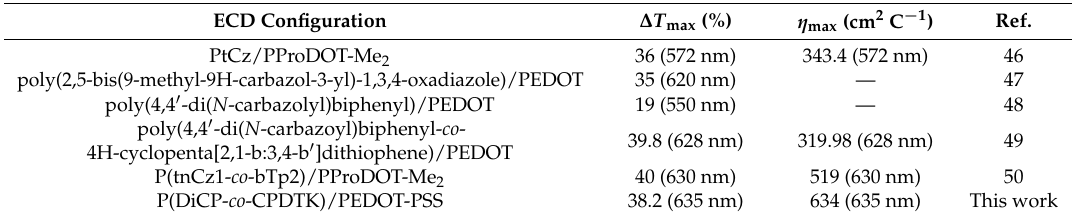
Table 7. Transmittance changes and colouration efficiencies of